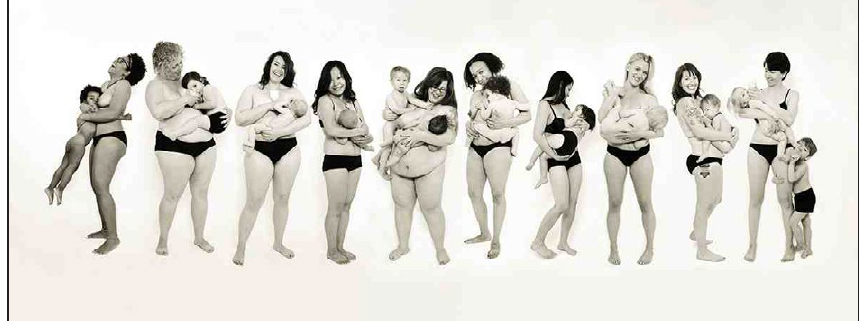
Figure 2: Ashlee Wells Jackson, untitled montage of breastfeeding mothers,